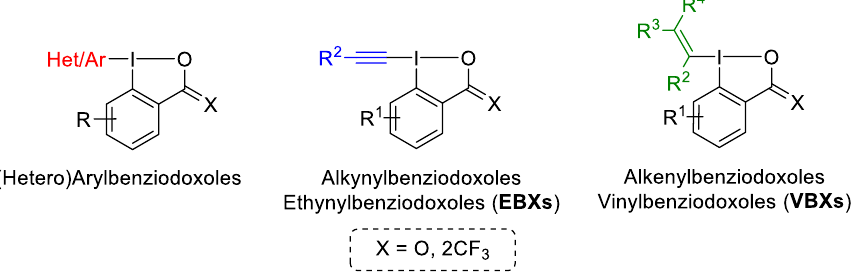
Figure 1. Arylbenziodoxoles, ethynylbenziodoxoles, and